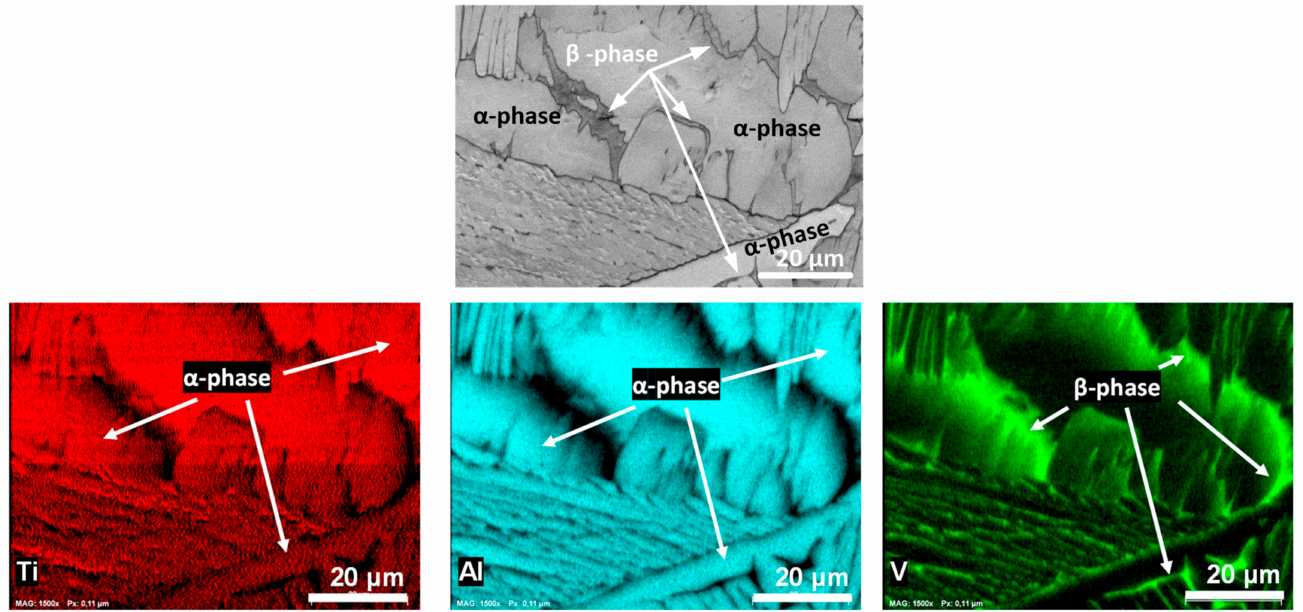
Figure 4. SEM image at high magnification (1500 × ) showing α and β phases, and EDS maps identifying α and β phases on the Ti, Al, and V distribution maps of PT2